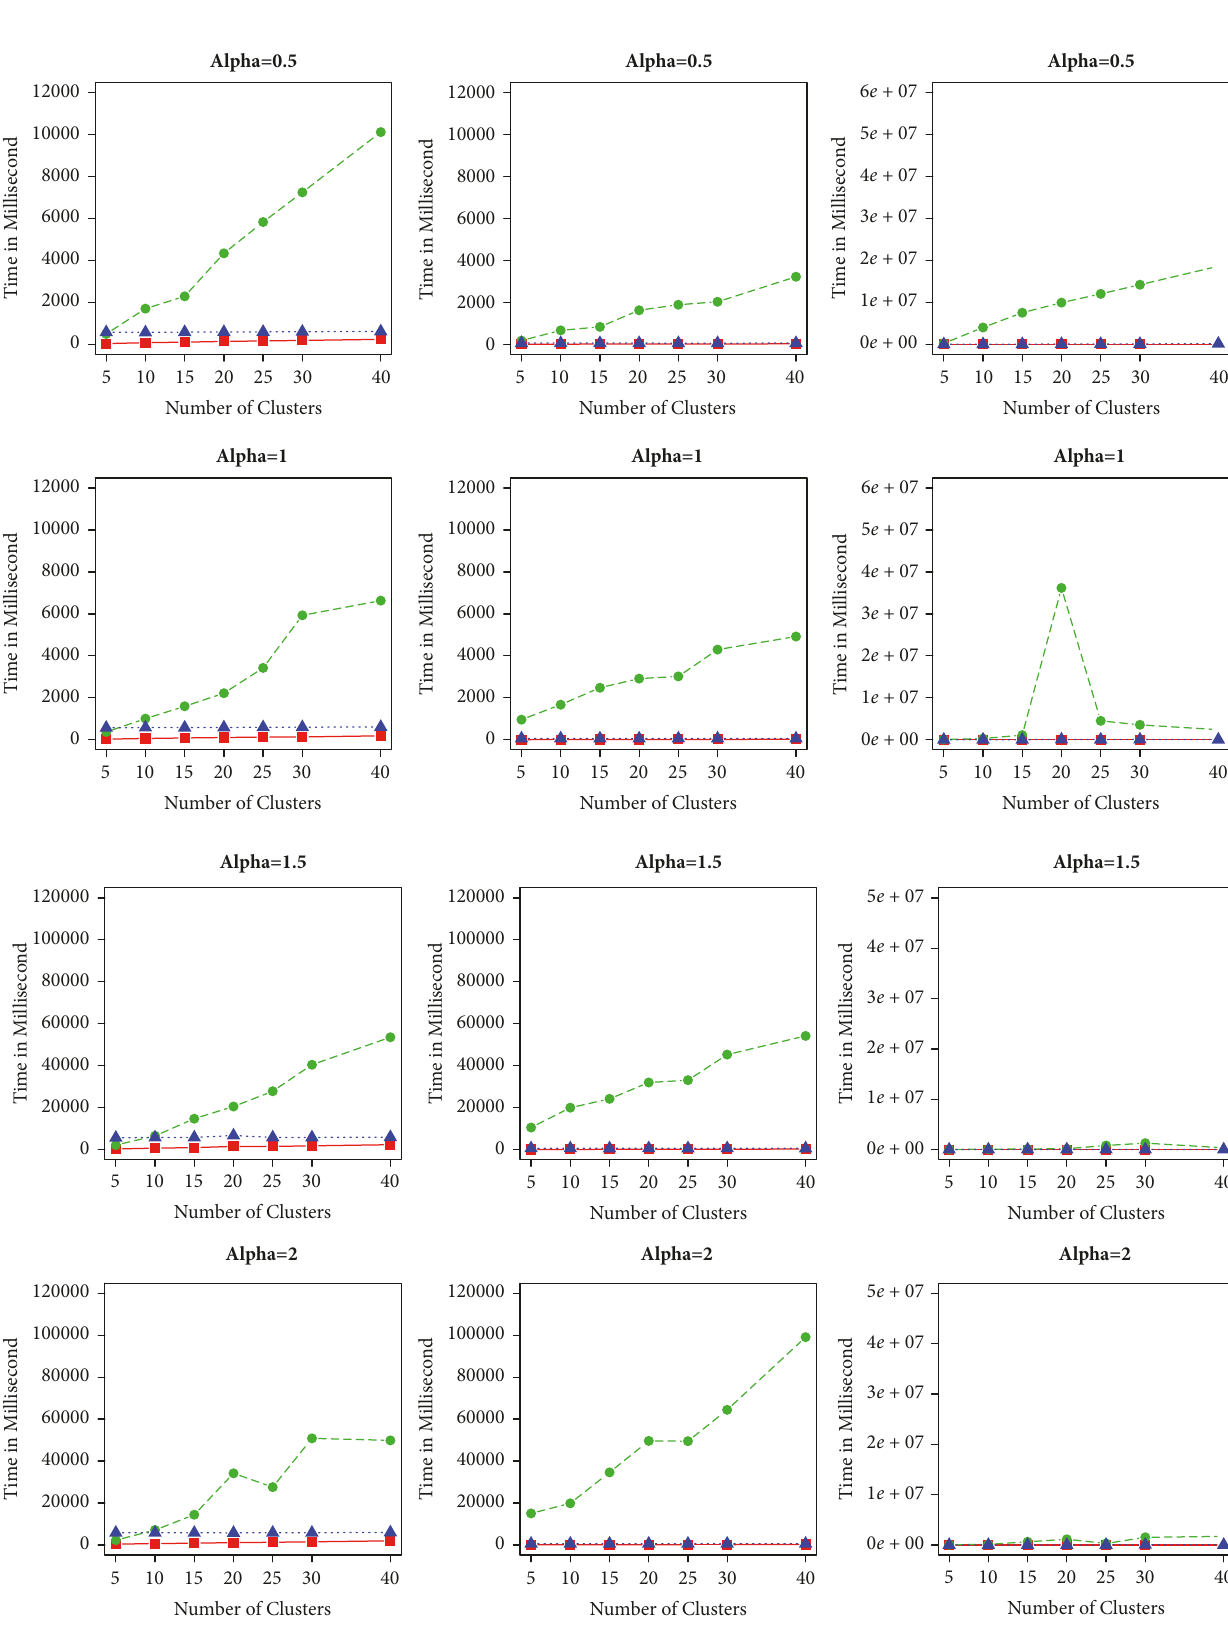
Figure 2: Comparison of KM, CM, and KCM algorithms in terms of time processing based on Euclidean, Manhattan, and Minkowski (𝑝 = 1.5) distances for 𝛼 = 0.5, 1, 1.5, 2. KM: Red squares, CM: Green circles, KCM: Blue